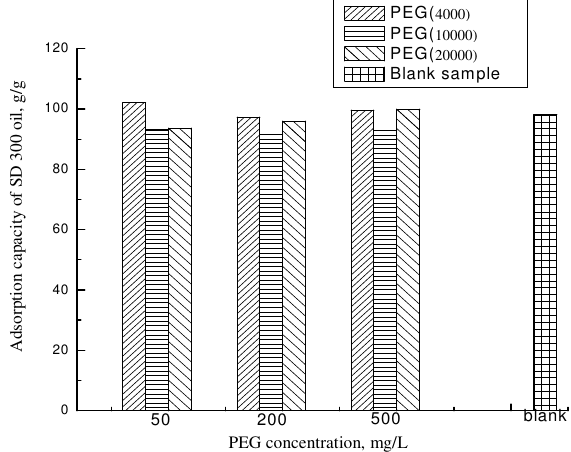
Figure 4. Stepwise adsorption capacity of SD 300 oil on EG